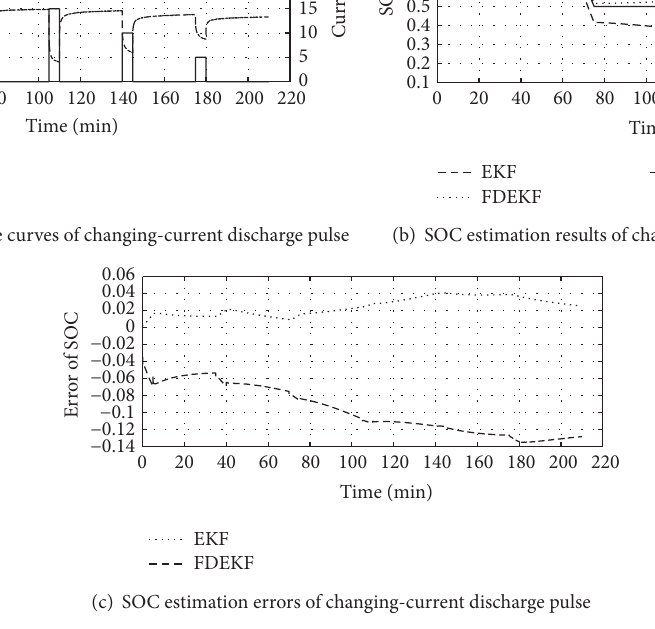
Figure 7: Comparison of SOC estimation and error curve of changing-current discharge pulse.